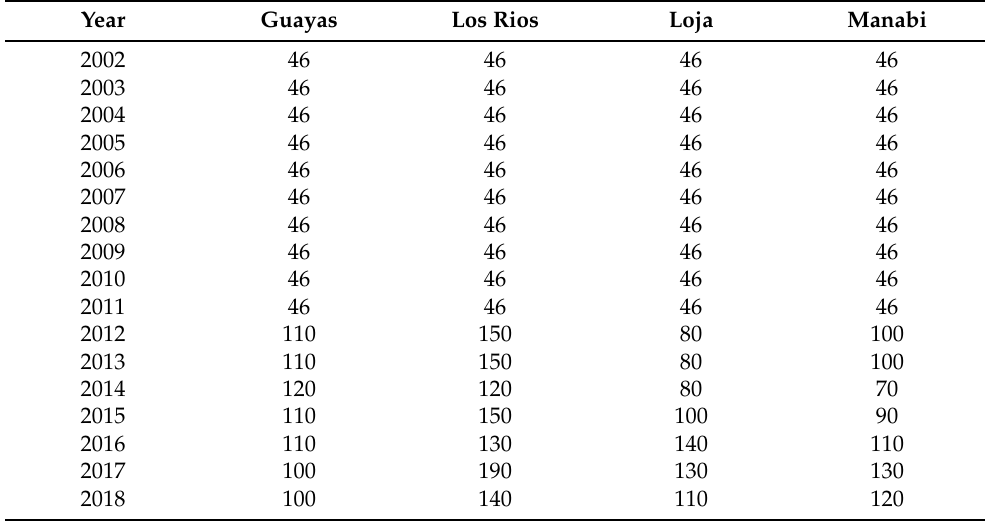
Table 1. Nitrogen application rate kg ha − 1 used in the model from 2002 to 2018 by province. The simulated yield was compared with the observed yield to validate the solution